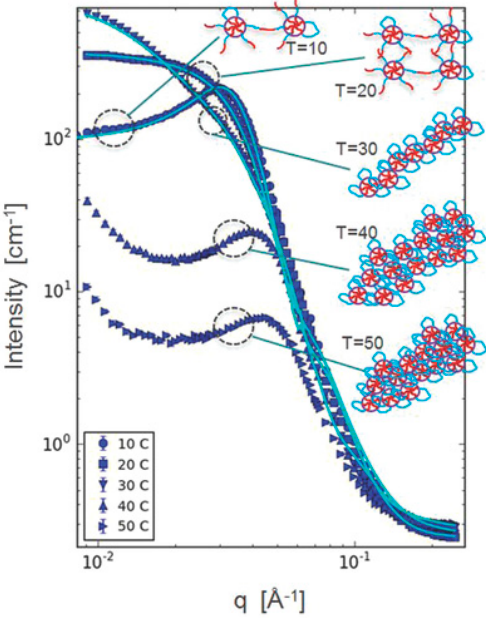
Figure 1. Structural analysis of PLGA–PEG–PLGA solution (20 wt%) by SANS. Reprinted from [24]